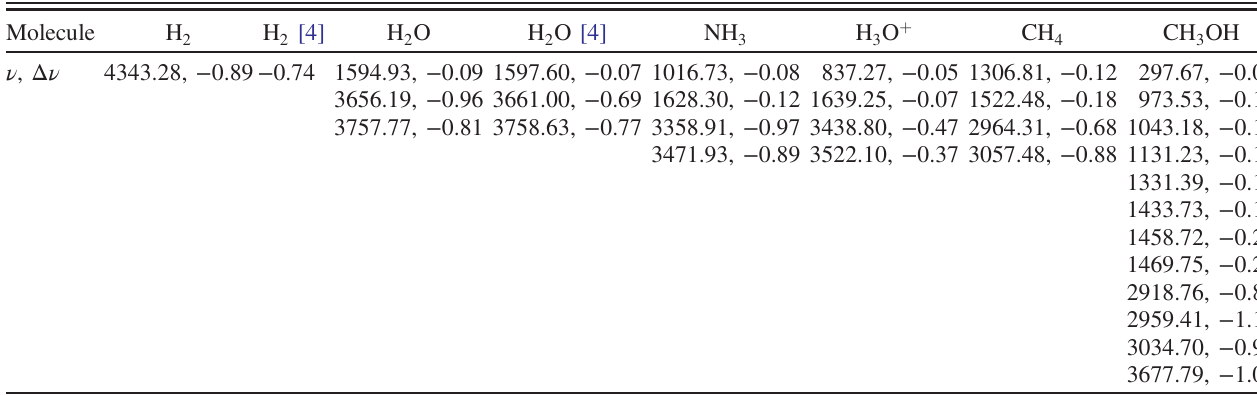
TABLE III. Harmonic frequencies ν (in cm − 1 ) and their nonadiabatic corrections Δ ν . Benchmark values are taken from Ref. [4] when indicated. They have been calculated using a SCF approach for the ground state and including the nonadiabatic corrections in a single- excitation CI framework. Differences are observed in the predicted frequencies ( ν ), which might be ascribed to the use of a different electronic structure approach and to the fact that in Ref. [4] the diagonal BO correction term has been included in the calculation of the ground-state potential for the vibrational